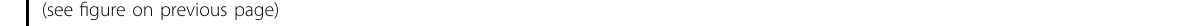
Fig. 2 Instrumental and discrimination learning: all sessions. A – D Individual data are shown as dots. The effect size and 95% con fi dence intervals obtained from bootstrapping are plotted on separate axes beneath the individual data points. For each genotype, mean ± standard deviations are shown as vertical gapped lines. A , B The number of sessions. A Instrumental learning. The number of sessions the rats needed to reach the learning criterion. There was no difference in the number of sessions needed between WT and KO rats. B Discrimination learning. The number of sessions the rats needed to reach the learning criterion or quit. There was no difference in the number of sessions needed between them. C , D Learning rate. C Instrumental learning. The instrumental learning rate was not signi fi cantly different between KO and WT rats. D Discrimination learning. The discrimination learning rate was not signi fi cantly different between KO and WT rats. E Discrimination accuracy. Mean percentage with 95% con fi dence intervals of correct responses across all learning sessions. The stimulus discrimination accuracy increased signi fi cantly as learning progressed in both WT and KO. There was no signi fi cant difference in correct responses across all learning sessions between KO and WT rats. F Response time during discrimination. Mean with 95% con fi dence intervals of response time across all learning sessions. The response time decreased signi fi cantly as learning progressed in both WT and KO rats. Genotypes were not signi fi cantly different. E , F WT ( N = 8), KO ( N =